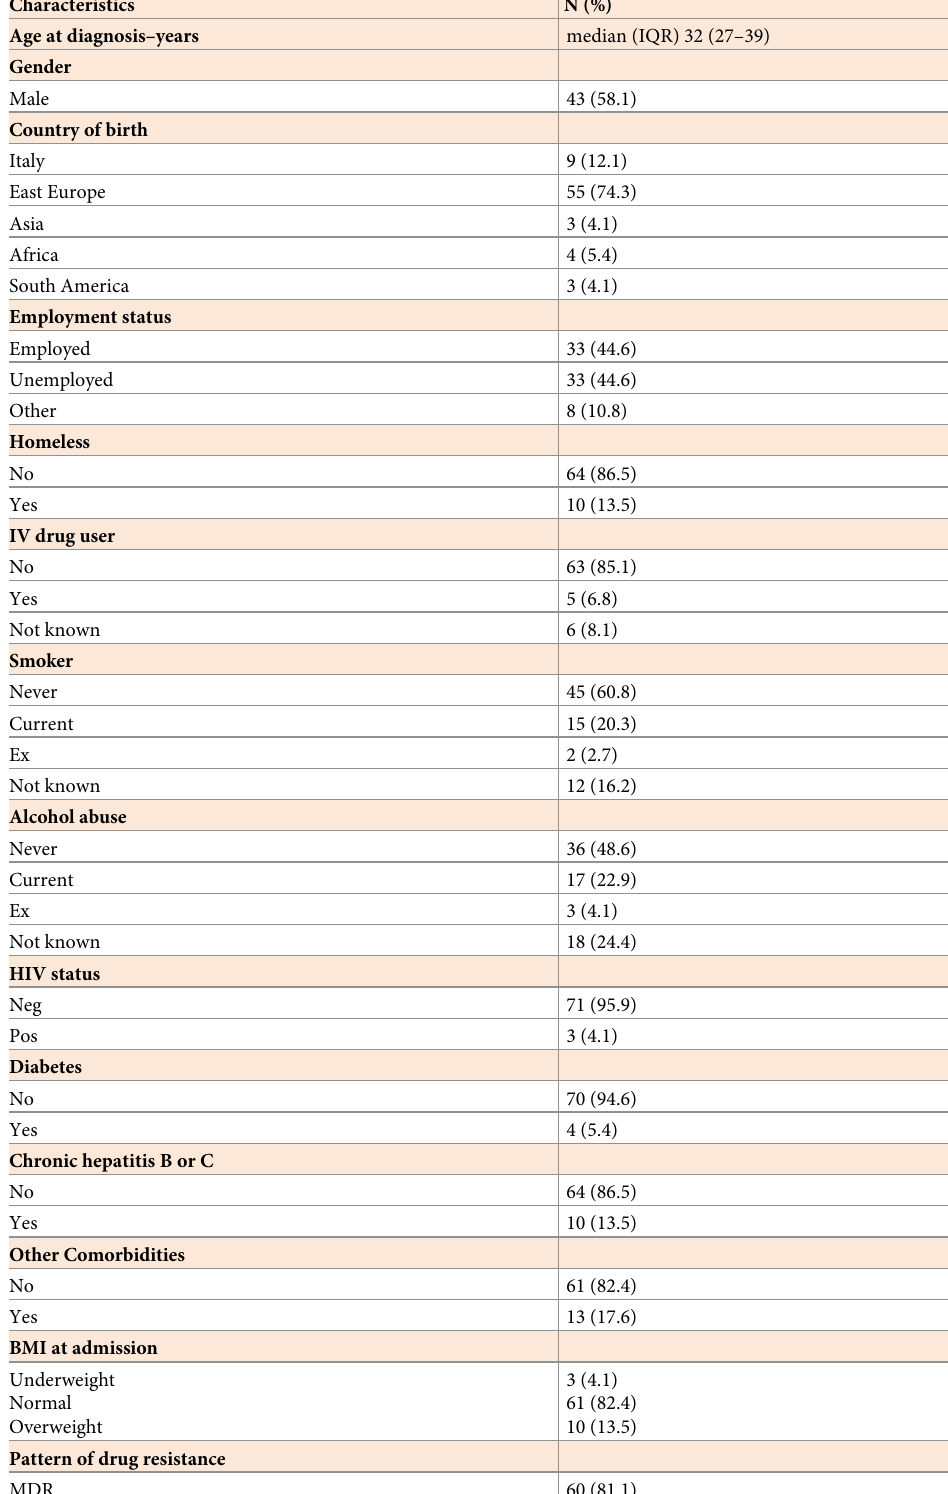
Table 1. Characteristics of 74 TB-MDE Patients,